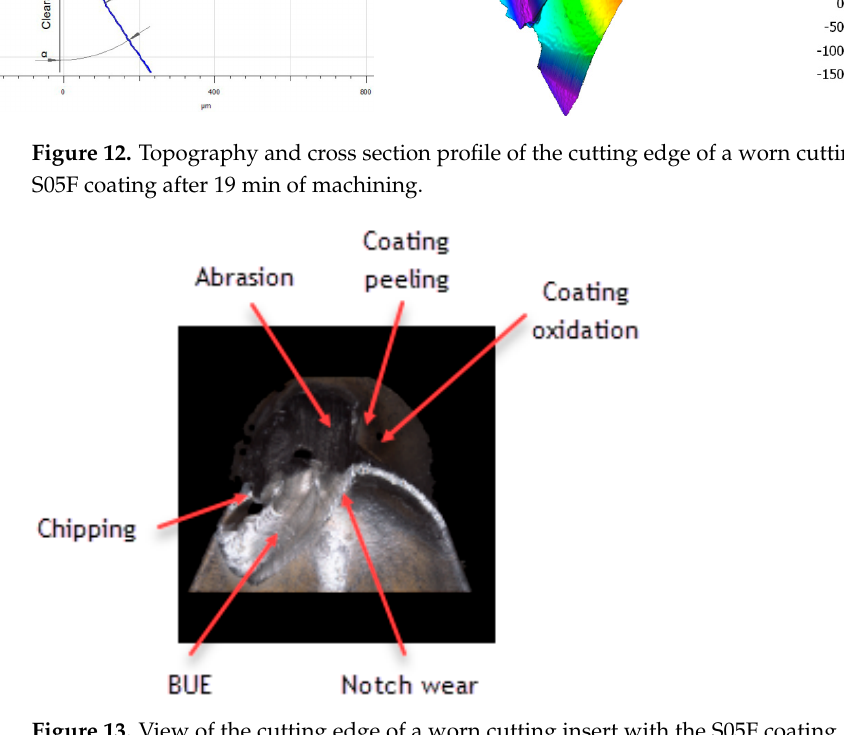
Figure 13. View of the cutting edge of a worn cutting insert with the S05F coating.